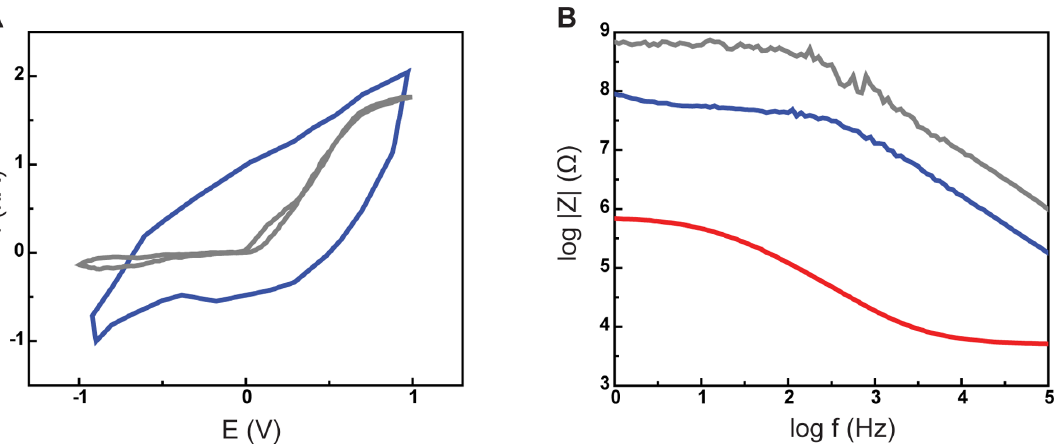
Figure 4. Impedance characterization of CNT probes. (A) Cyclic Voltammetry (CV) shows the CNT probes (with the insulation and FIB cut) have significantly larger charge transfer (blue line), compared to the sharp intracellular-recording glass pipette (gray line). (B) Electrochemical impedance spectroscopy (EIS) shows significantly lower impedance of the CNT probe (blue line) compared to the glass pipette (gray line) over the frequency range of 1 to 100 kHz. Successful insulation-coating plus FIB-cutting reduces contact area between the CNT probe and solution by a few orders of magnitude, which explains the difference between the curves measured before coating (red line) and after FIB cutting (blue line).